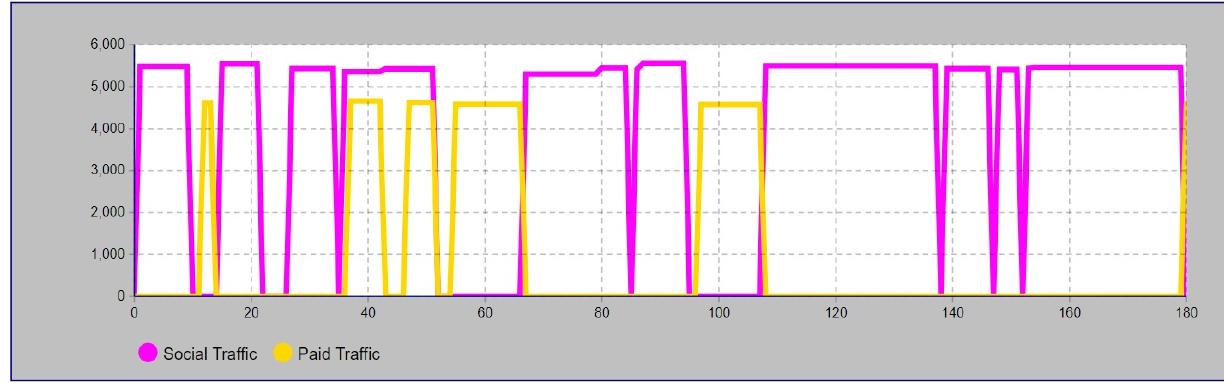
Figure 7. The time chart depicts the history of the contribution of the following traffic factors: Social traffic and Paid Traffic during 180 days.